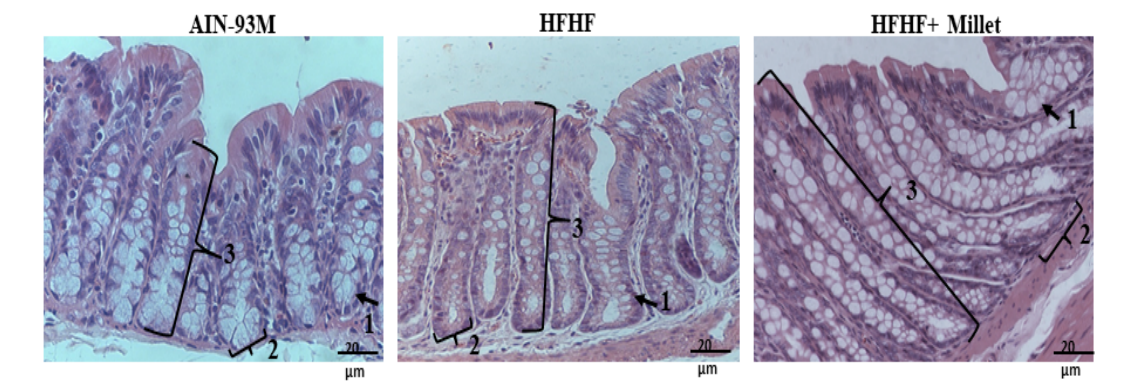
Figure 2. Effect of germinated millet flour on the histomorphometry of the colon. Number of goblet cells (1) and crypt thickness (2) and depth (3), after 10 weeks of intervention. AIN-93M: standard diet; HFHF: high-fat high-fructose diet; HFHF + millet: HFHF diet + 28.63% of germinated millet flour. Staining was carried out with hematoxylin and eosin. Bar: 20 μ m. Objective: 20×.